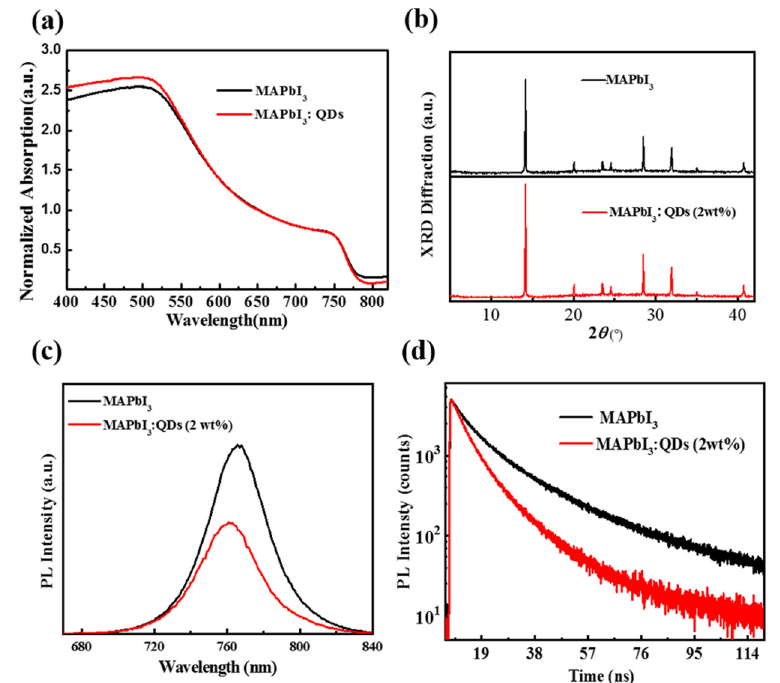
Figure 4. ( a ) UV-VIS absorption spectra; ( b ) XRD pattern; ( c ) steady-state photoluminescence spectra; ( d ) time-resolved photoluminescence of perovskite films spectra without and with CsPbI 3 QDs.